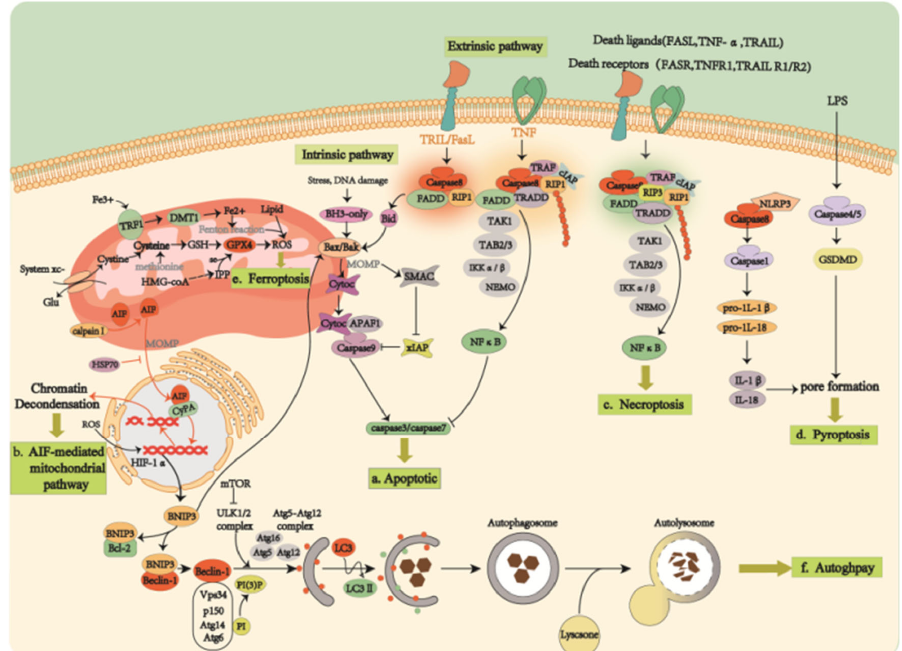
Figure 3. Part of the cell death mechanism. Schematic diagrams are represented as: ( a ) Activation of multiple protein complexes by caspase ‐ 8 induces caspase ‐ dependent apoptosis; ( b ) AIF ‐ mediated mitochondrial pathway induces caspase ‐ independent apoptosis; ( c ) Necroptosis performed by RIPK1 and/or RIPK3; ( d ) Pyroptosis caused by the immune response activation of caspase family members; ( e ) Ferroptosis caused by the excessive oxidation of membrane lipids; ( f ) Atg family ‐ mediated autophagy ‐ dependent cell death.